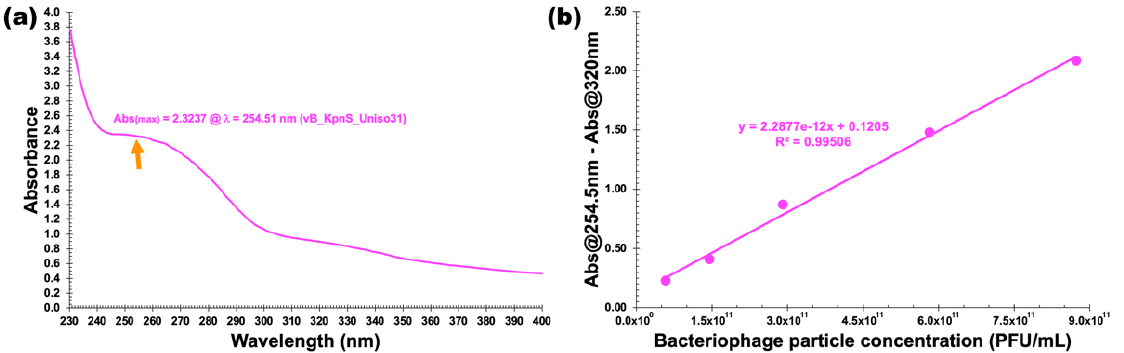
Figure 9. UV–VIS spectral scan of Kpn31 phage particles ( a ) and the relationship between the concentration of phage Kpn31 and its corrected absorbance ( b